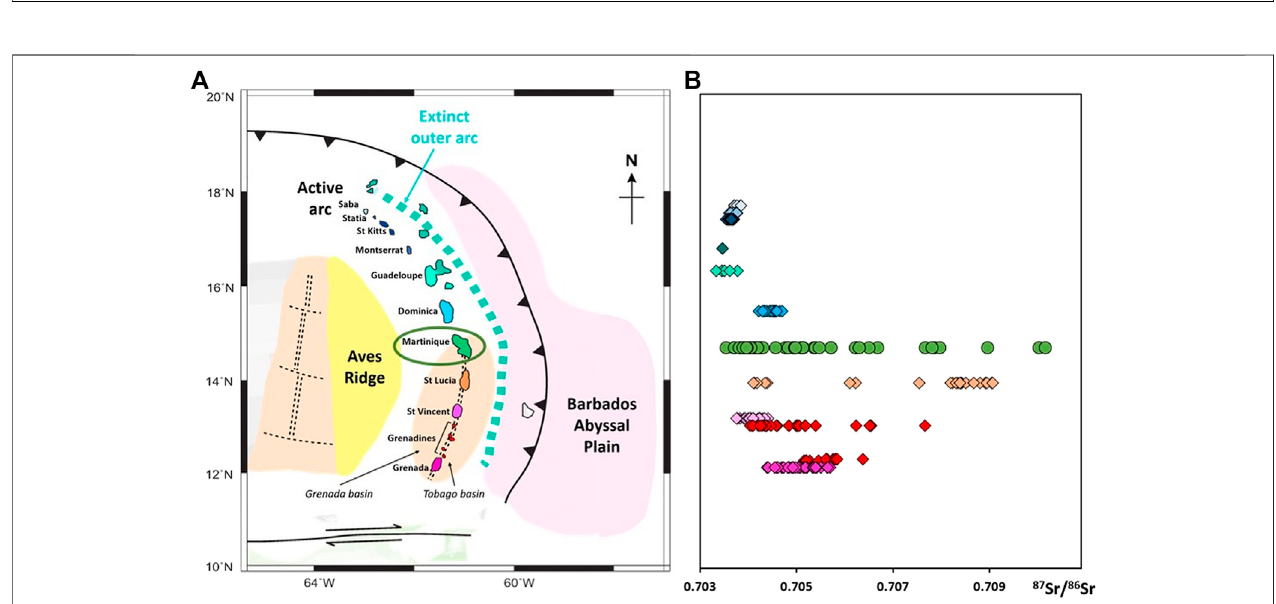
FIGURE3|(A) MapofLesserAntillesarc(regionmarkedbyblackoutlinedboxon Figure1 )modi fi edfromAllenetal.(2019). (B) Compilationofalongarcvariation in 87 Sr/ 86 Sr of lavas. For all data points, uncertainty (2 SE) is smaller than symbol size. Data sources are the same as Figure 2 . Note that the same along arc trends are also observed in the Nd and Pb isotopic